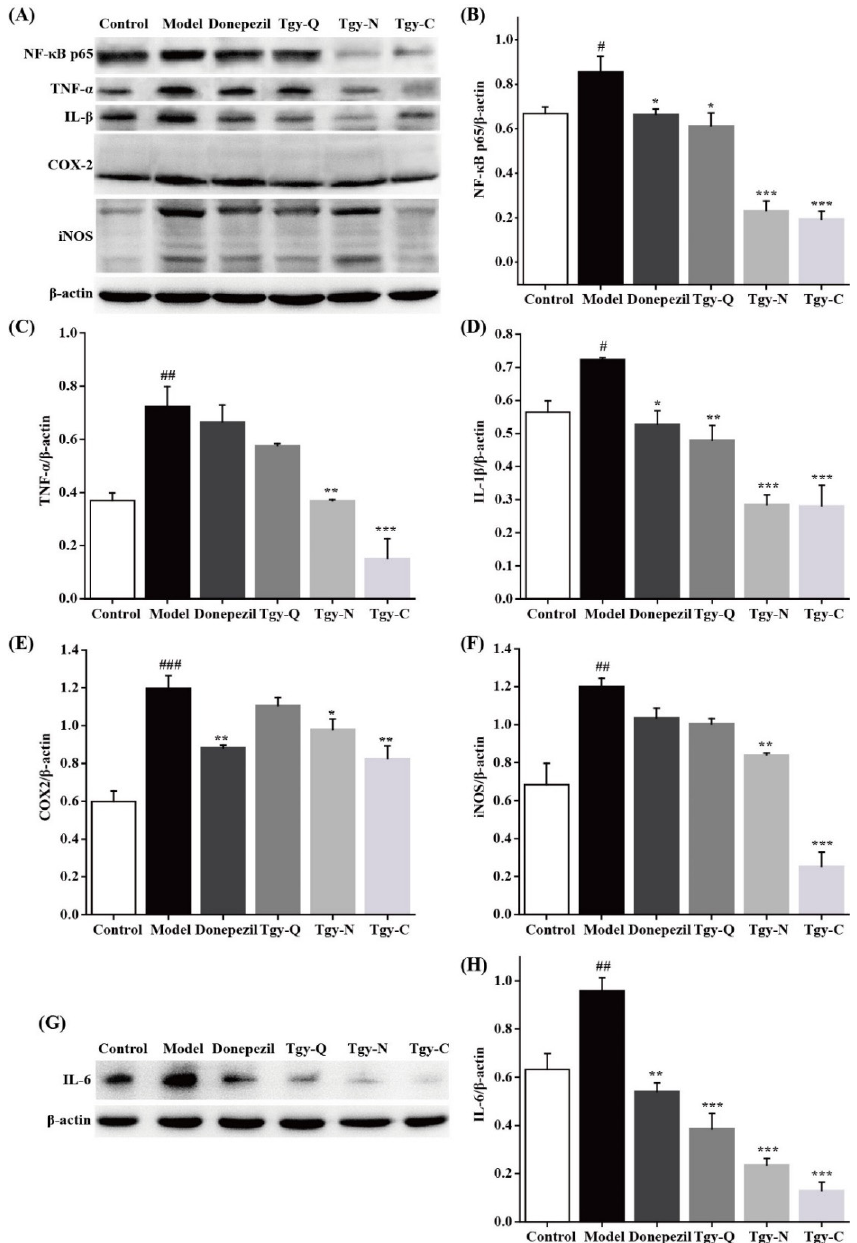
Figure 7. Tiguanyin extracts reduces the expression of inflammation related proteins in microglia. ( A – F ) Expression of NF- κ B, TNF- α , IL-1 β , COX-2, and iNOS in microglia in different groups. ( G , H ) Expression of IL-6 in microglia in different groups. Control group n = 7, n = 5 for